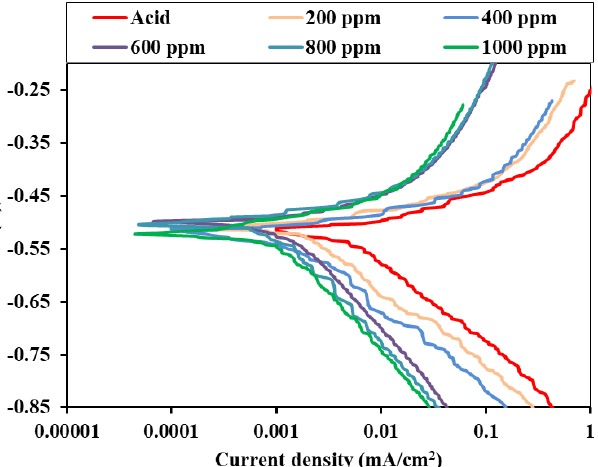
Figure 7. Potentiodynamic polarization curves for mild steel in 1 M H 2 SO 4 containing different concentrations of the inhibitor as-immersed condition.